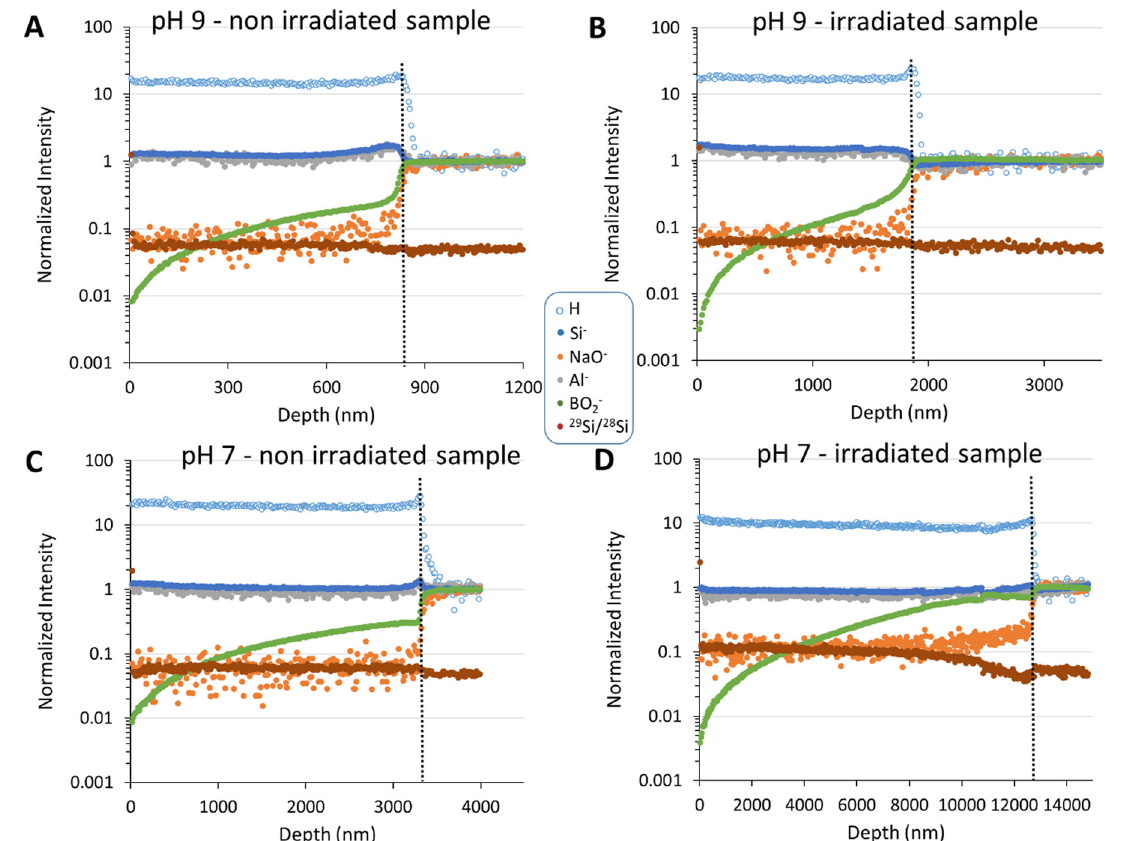
Fig. 7 ToF-SIMS elemental and isotopic mappings of sample E (non-irradiated glass altered for 83 days at pH 3 in silica saturation conditions). Note that the mappings are recorded within the green square shown on the optical image but do not correspond to the red